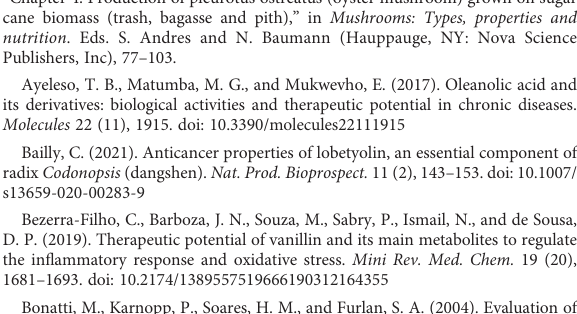
SUPPLEMENTARY FIGURE 1 The standard curve of lobetyolin. SUPPLEMENTARY TABLE 1 Overview of metabolomics